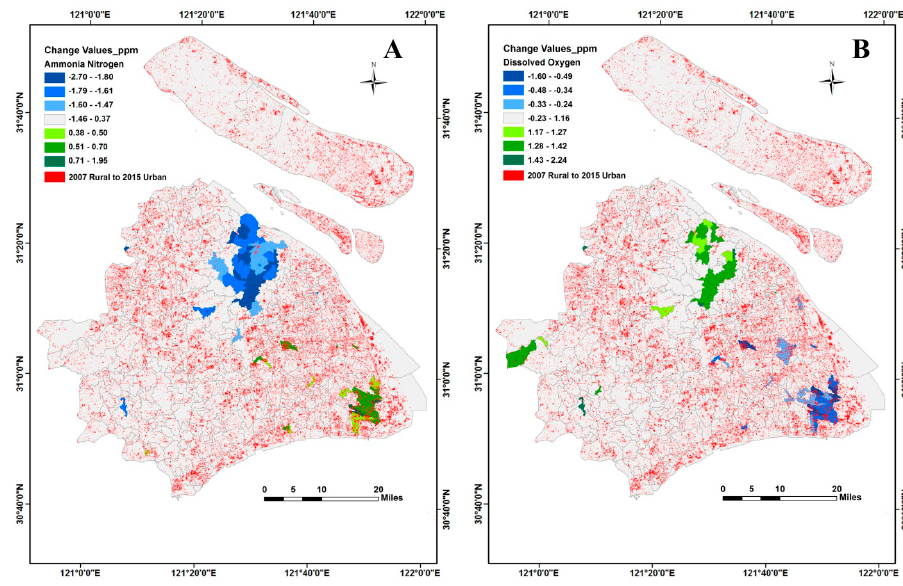
Figure 7. Water quality changes with urbanization from 2007 to 2015: ( A ) ammonia nitrogen changes and ( B ) DO changes.